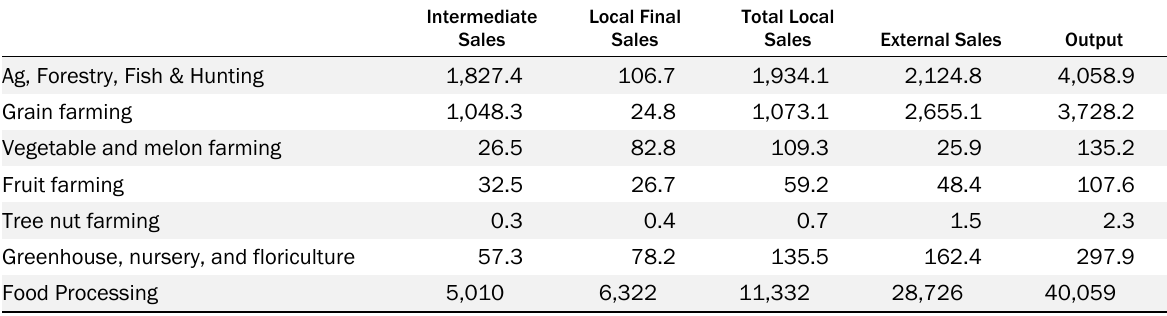
Table 3. Sector Demand Profiles (all in US$